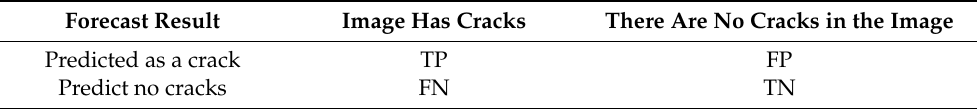
Table 7. Target detection model evaluation